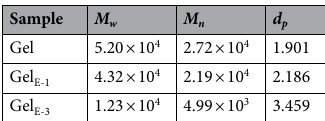
Table 3. GPC analysis of Gel molecular weight before and after electrolysis.